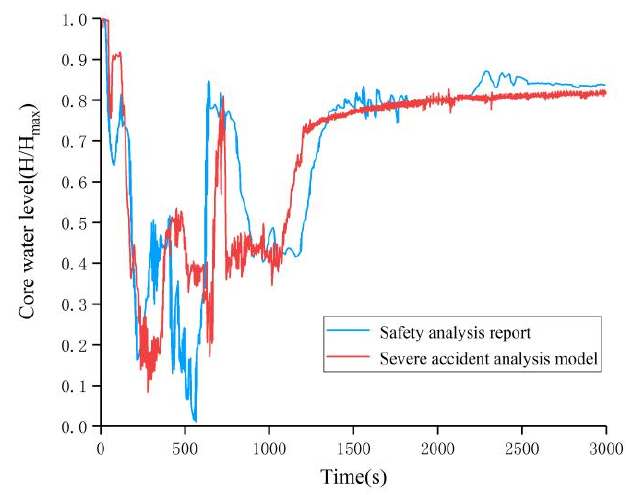
Figure 3. The variation curve of the pressurizer pressure over time.